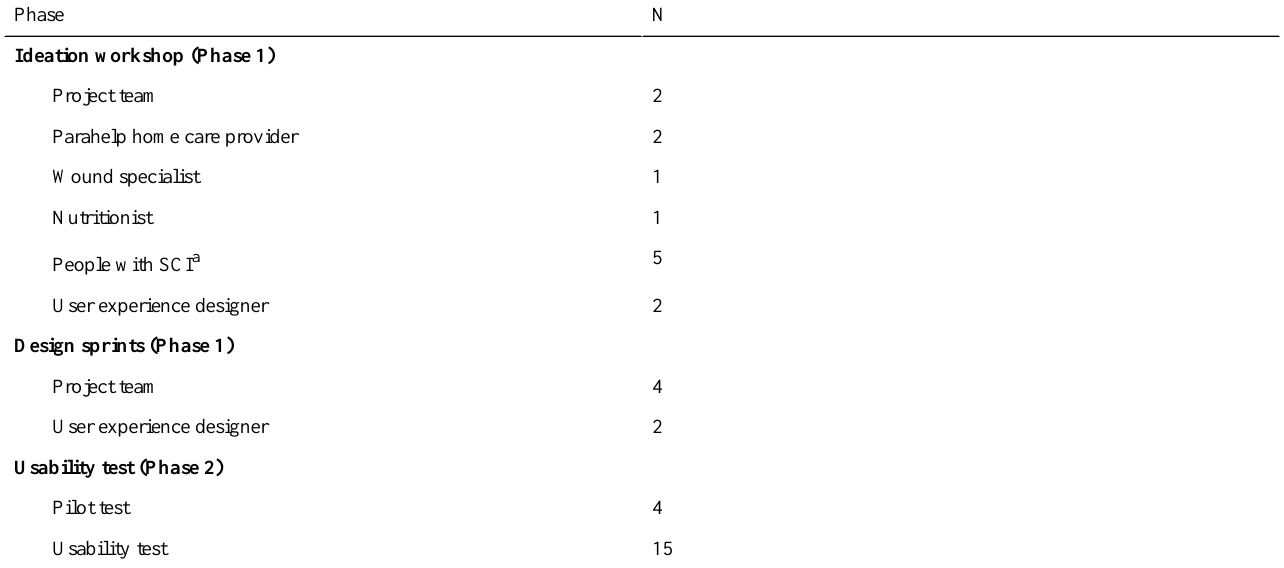
Table 1. Study participants in Phase 1 and Phase